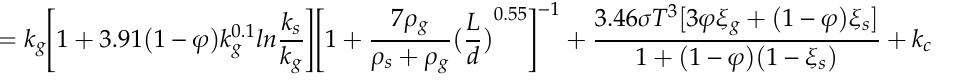
Table 1. Fluent simulation parameter setting.